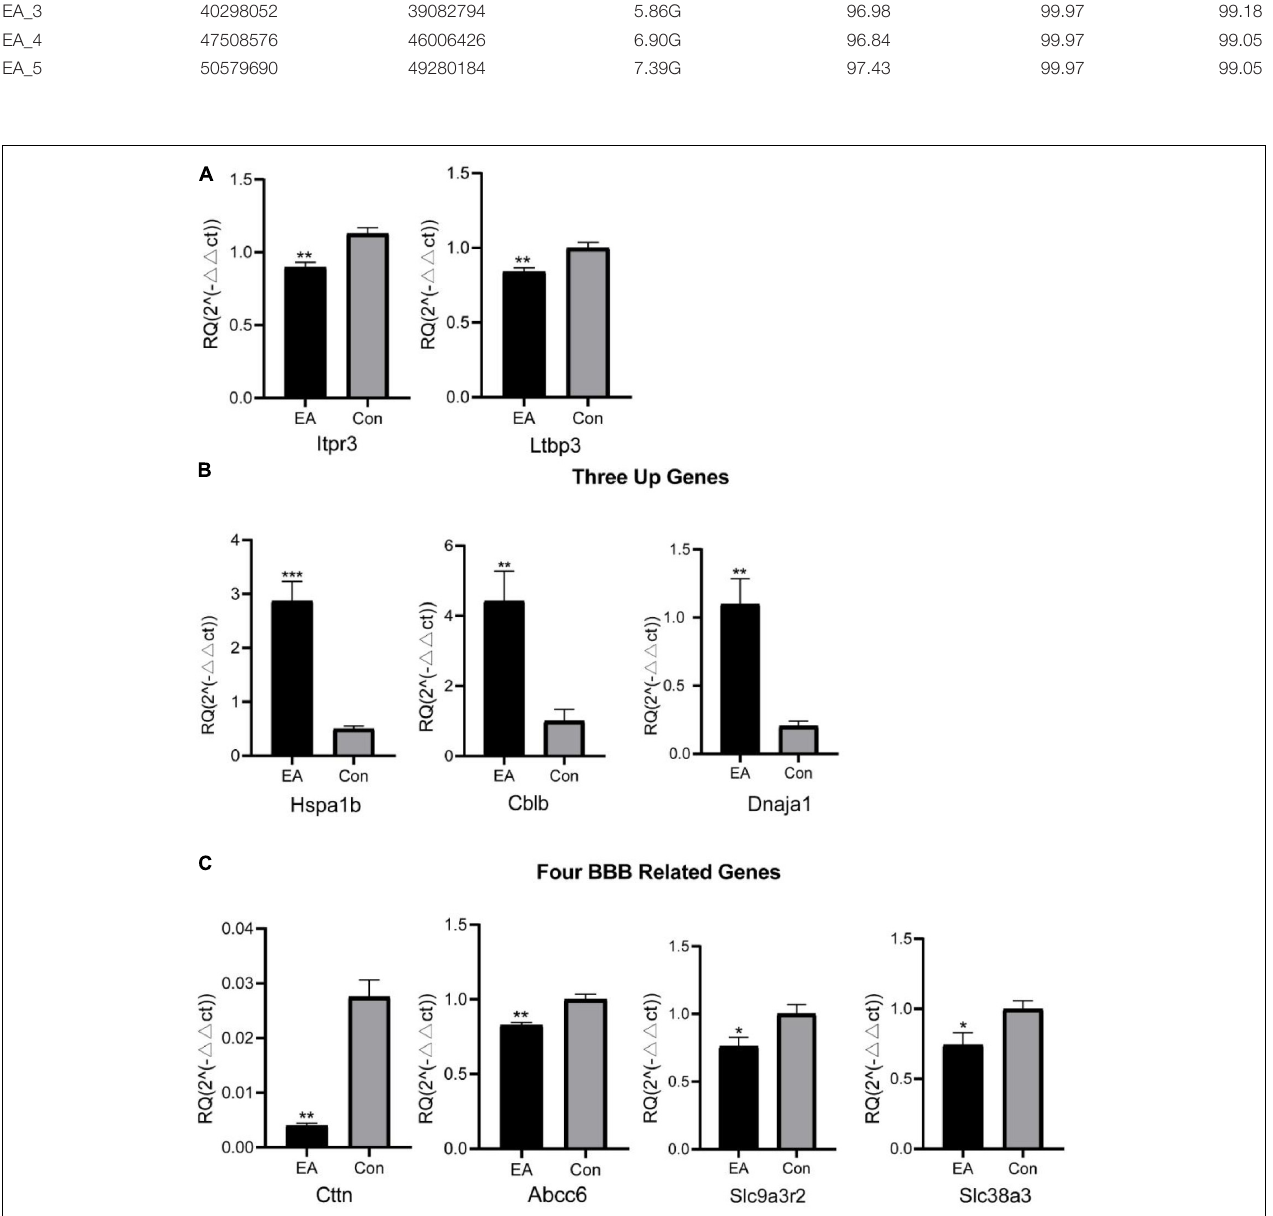
FIGURE 3 | RNA-Seq results were validated by qPCR. Two randomly selected down-regulated DEG expression (A) from RNA-Seq and three up-regulated DEG (B) expression were detected by qPCR, and (C) four typical genes related to BBB. * p < 0.05, ** p < 0.01, and *** p < 0.00. Student’s t -test was used for comparisons.